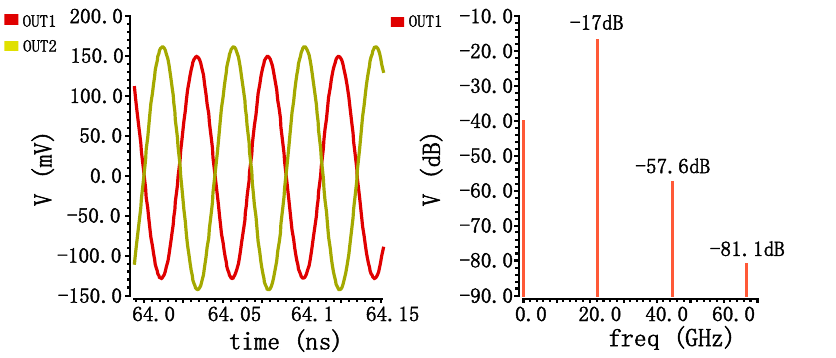
Figure 9. Post-layout simulation of VCO in minimum oscillation frequency and its spectrum.